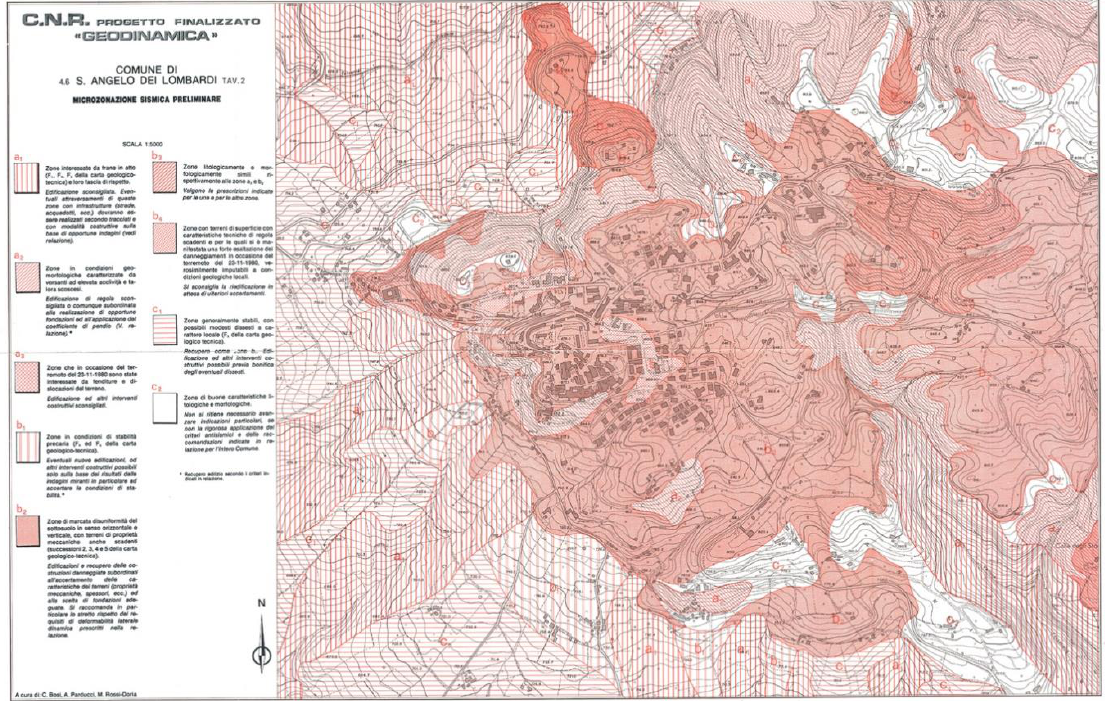
Figure 34. Sant’Angelo dei Lombardi: original map of the seismic microzonation according to [29].